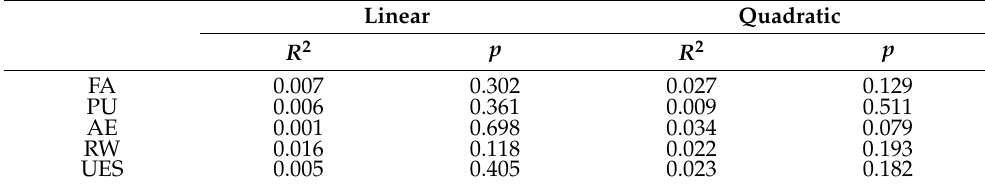
Table 7. Shot Length relation to user engagement scale (short form) for linear and quadratic model.